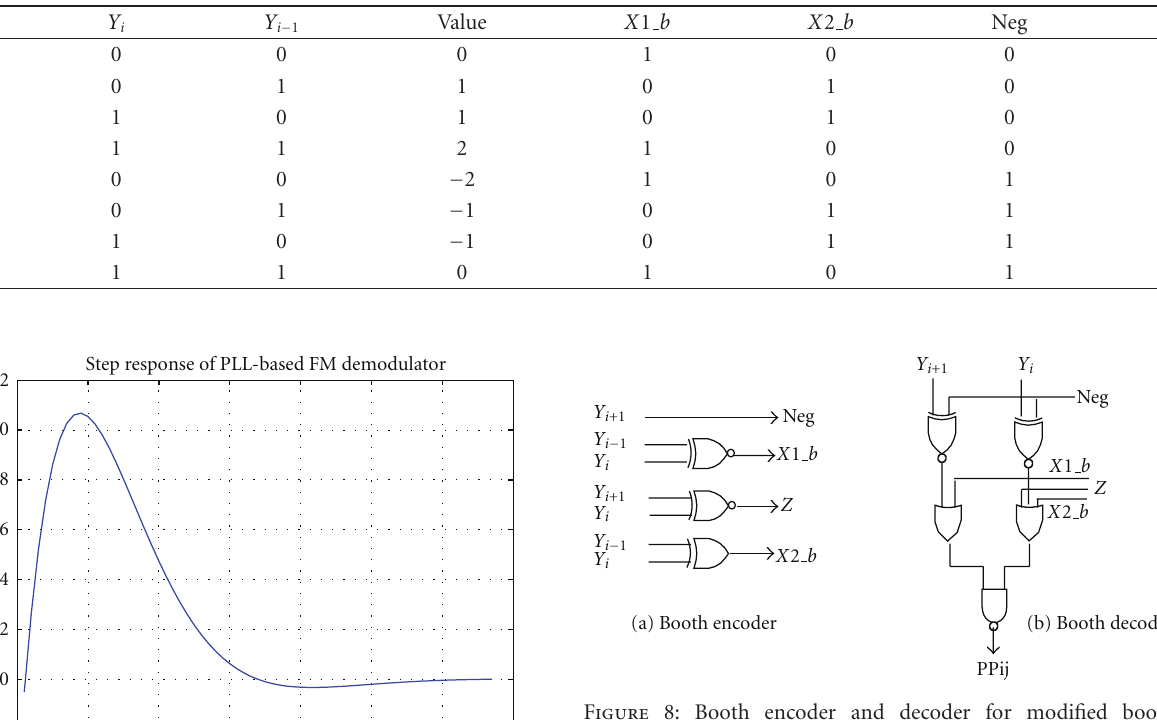
Table 1: Truth table of modified booth encoder.